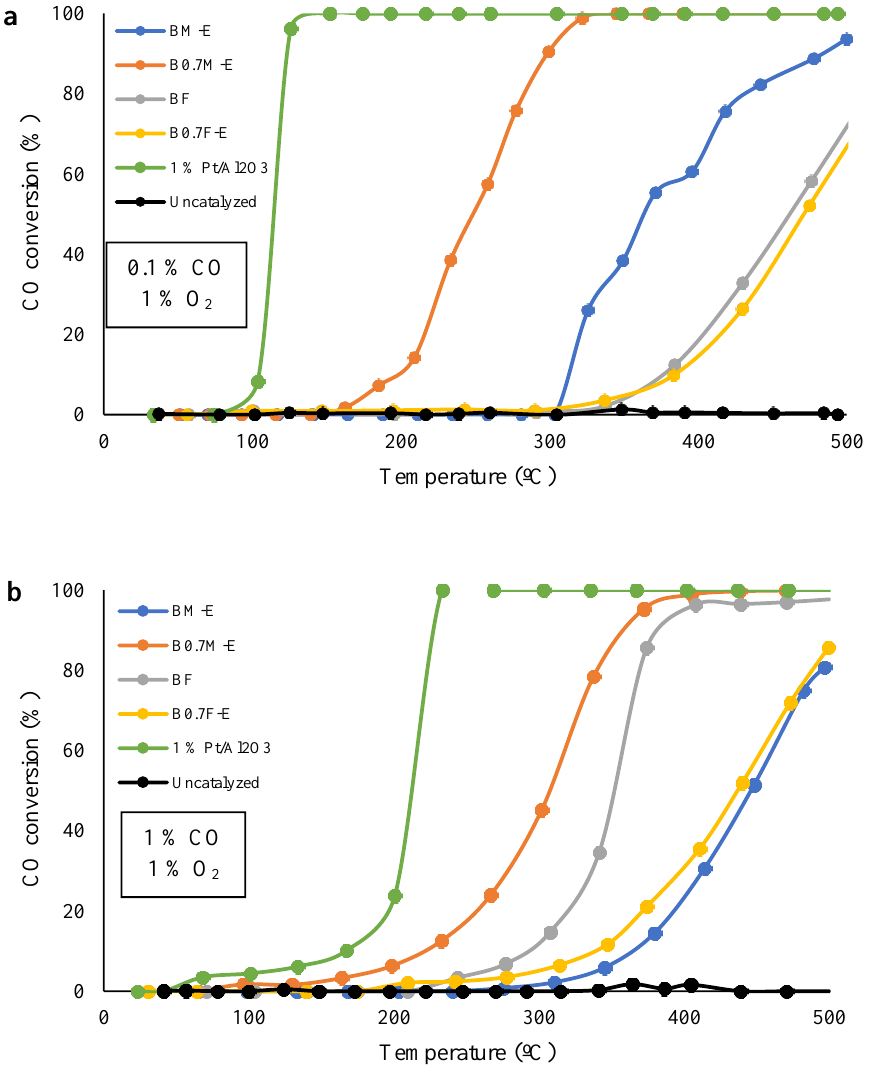
Figure 8. CO conversion profiles (CO-TPR) for the catalysts in 0.1% CO, 1% O 2 in He ( a ) and 1% CO, 1% O 2 in He ( b ).